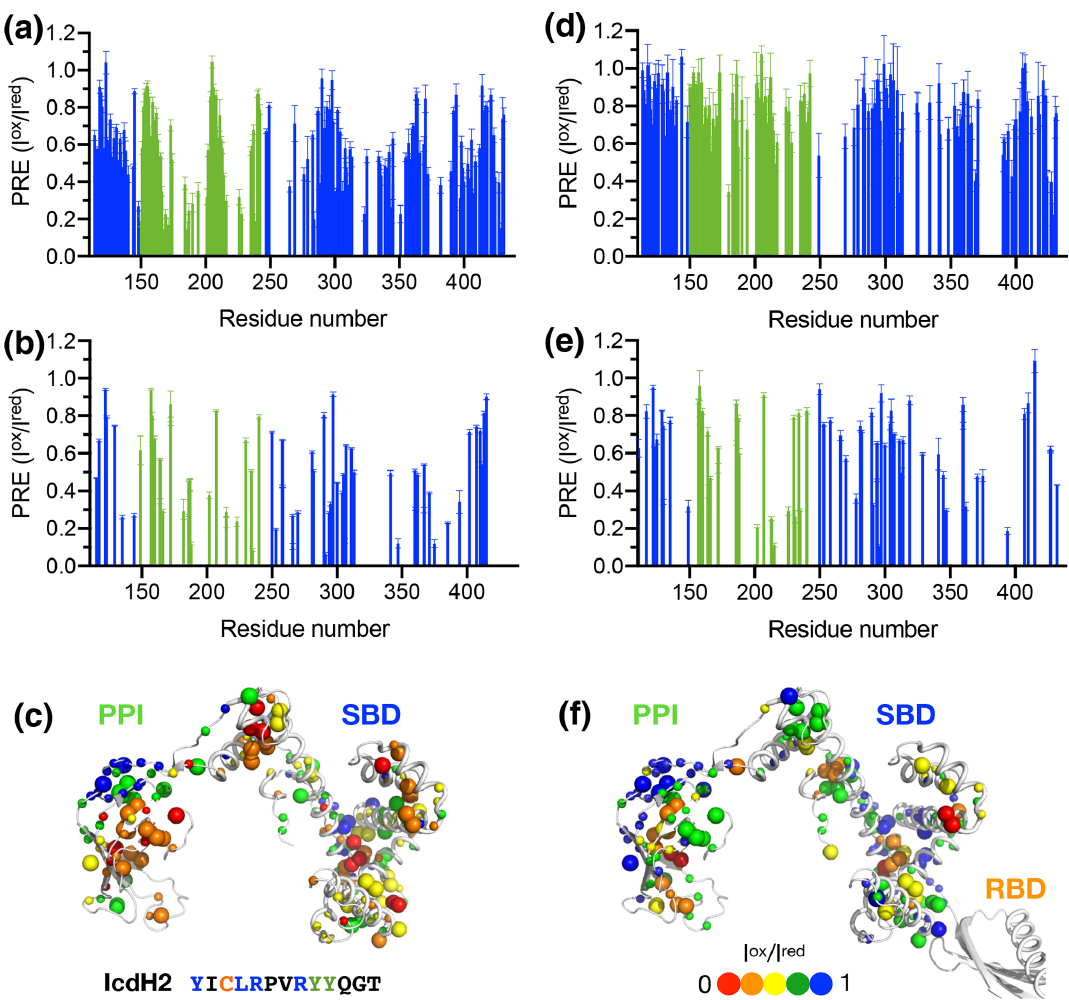
Figure 4. Structural mapping of the PREs induced by the MTSL-labeled IcdH2 peptide on TF without and with the RBD. The backbone amide-based PREs of PPI + SBD (a) and full-length TF (d) . The side-chain methyl-based PREs of PPI + SBD (b) and full-length TF (e) . Structural mapping of the observed PREs onto the structure of PPI + SBD (c) and full-length TF (f) . The backbone amide nitrogen atoms and side-chain methyl carbon atoms are shown by small and large spheres and are colored with a gradient from red to blue, corresponding to small and larger PREs as indicated by the filled circles below. The observed PREs expressed as the ratio of the peak intensities of the oxidized (paramagnetic state) to the reduced (diamagnetic state) states ( I ox /I red ) as a function of residue number between 113 and 432. The PRE values corresponding to PPI and SBD are colored in green and blue, respectively. The residues corresponding to the RBD are omitted due to the severe line broadening that precludes reliable data